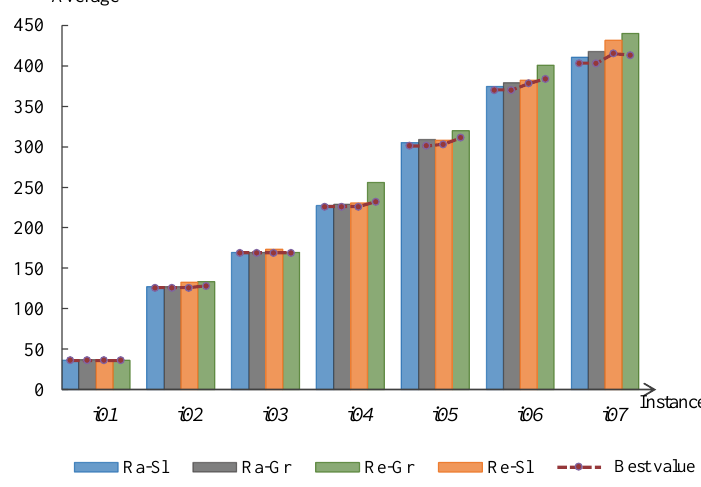
Figure 4. Average and the best objective values obtained by different combinations of destroy– repair